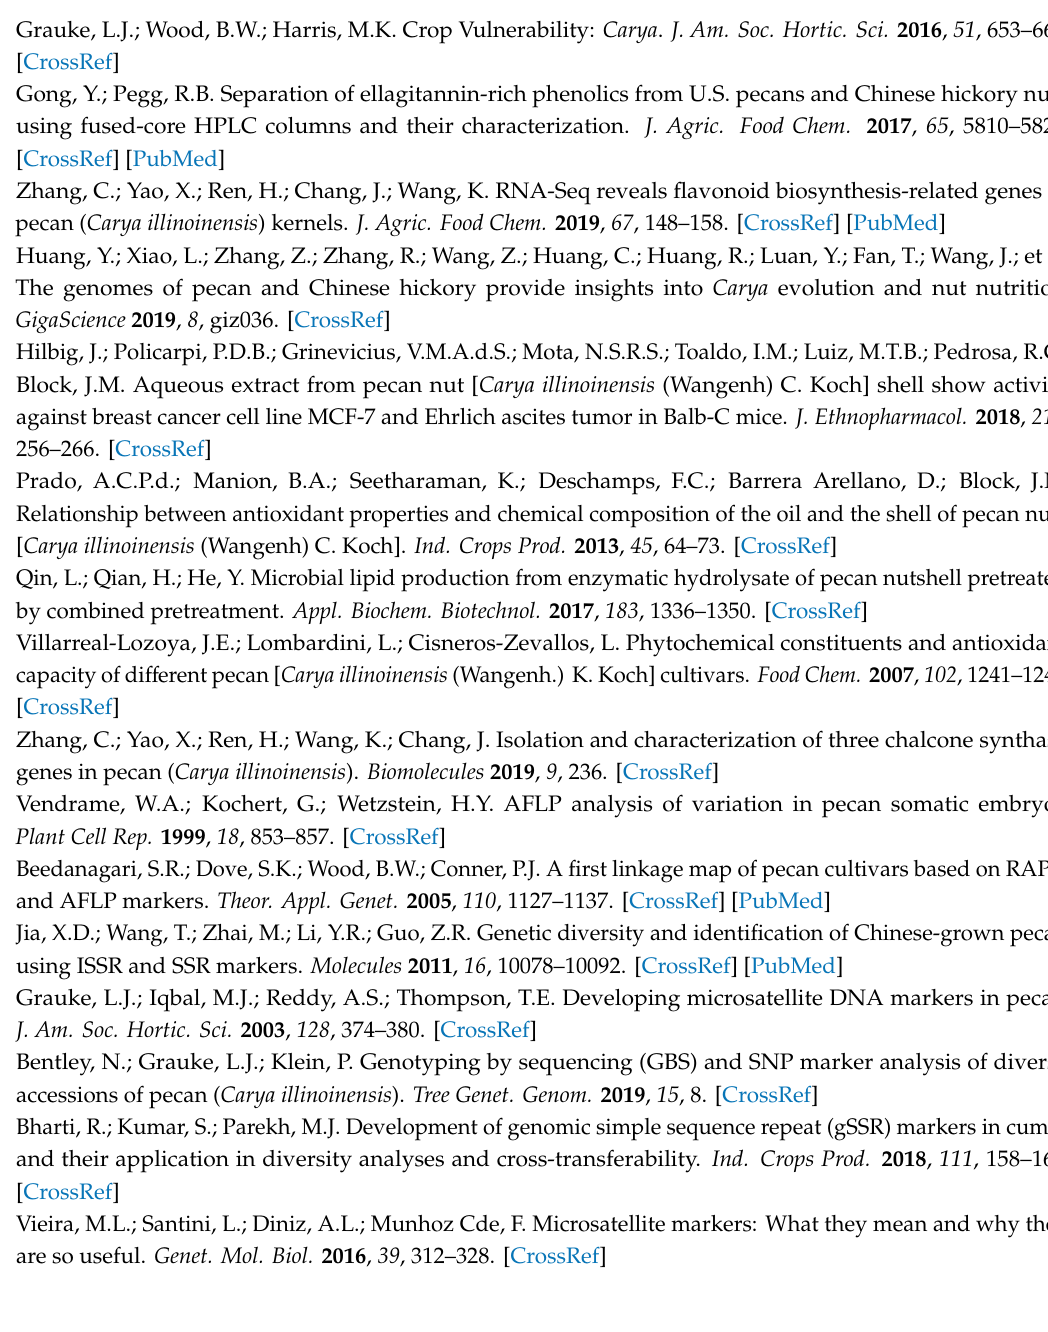
Table S1: The frequency of identified SSR motifs, Table S2: The information of primers, Table S3: The information of 66 primer pairs used in the present study, Table S4: The pedigree information of 21